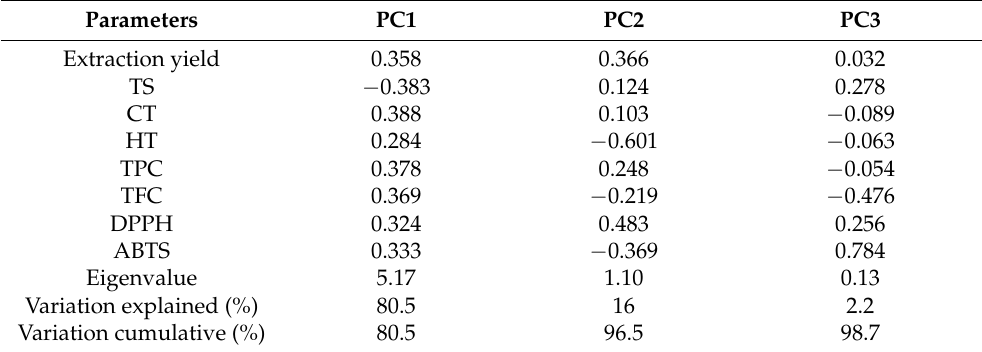
Table 1. Vectors and values of the main principal components (PC), which represent the extraction yield, the bioactive compounds, and the antioxidant activity of different MO